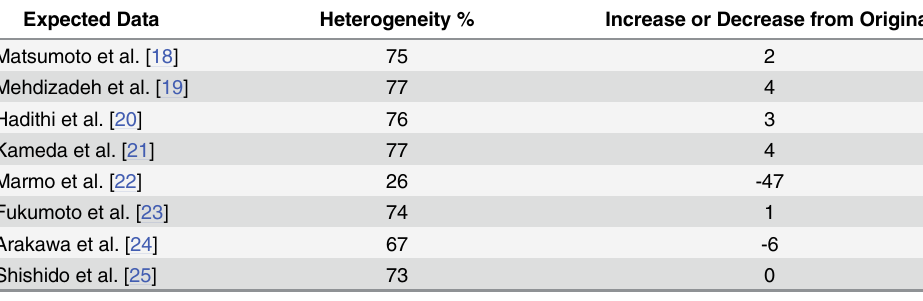
Table 3. Changes in the heterogeneity when each postmarketing study is excluded.